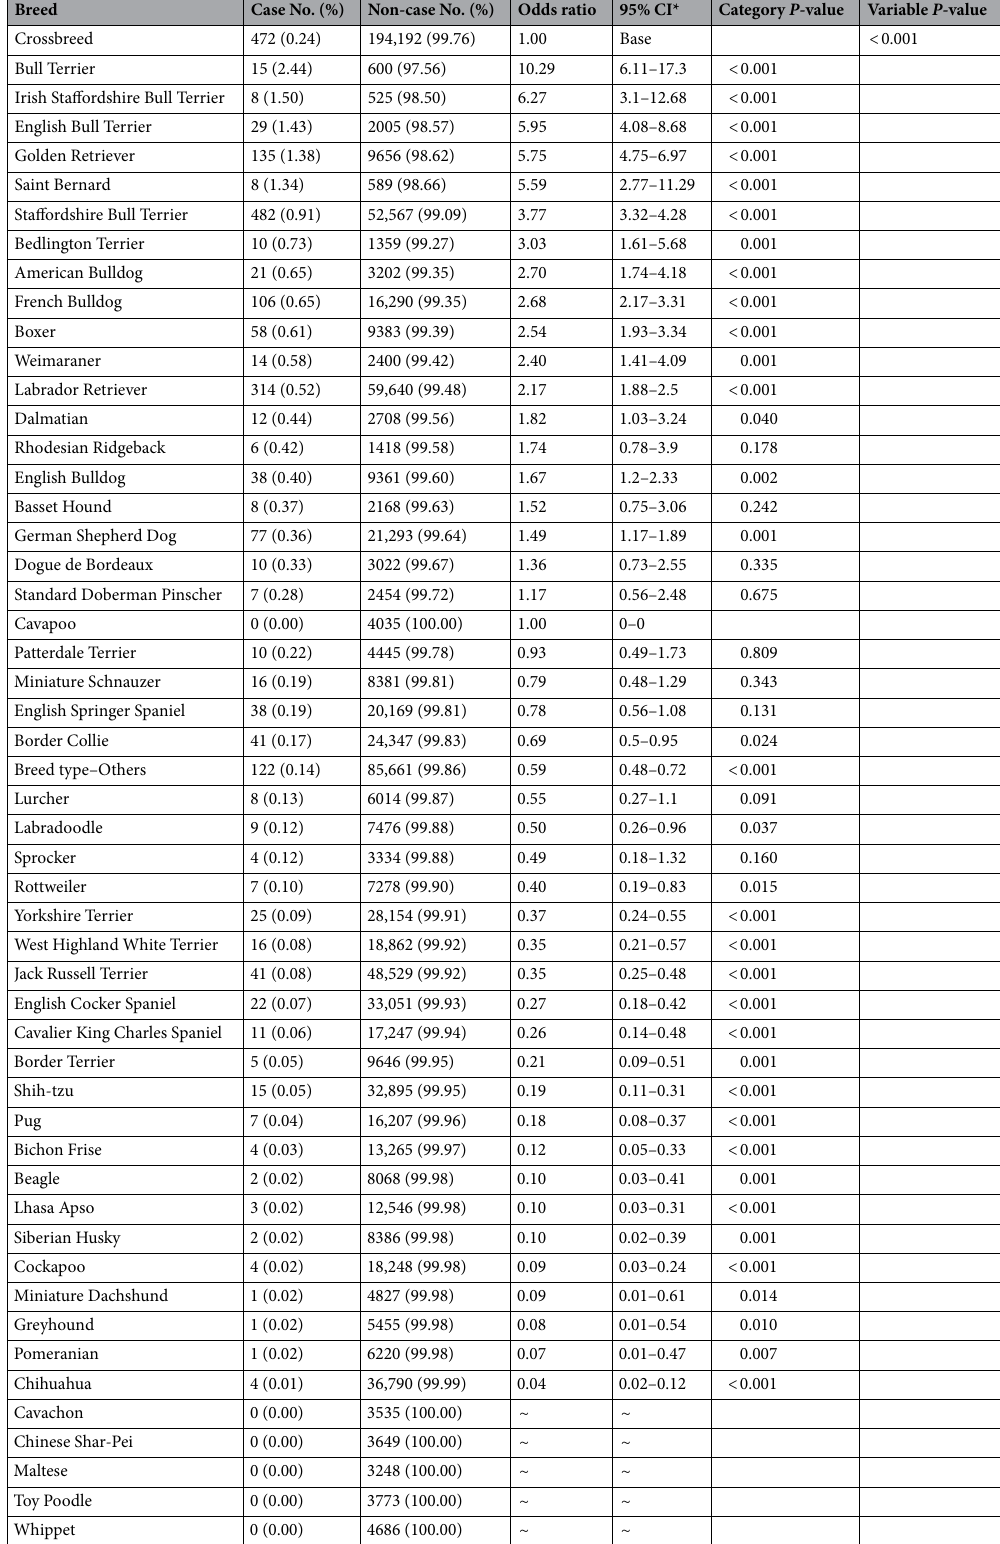
Table 1. Descriptive and univariable logistic regression results for various dog breeds as risk factors for aural haematoma during 2016 in dogs under primary veterinary care in the VetCompass™ Programme in the UK. Column percentages shown in brackets. *CI confidence